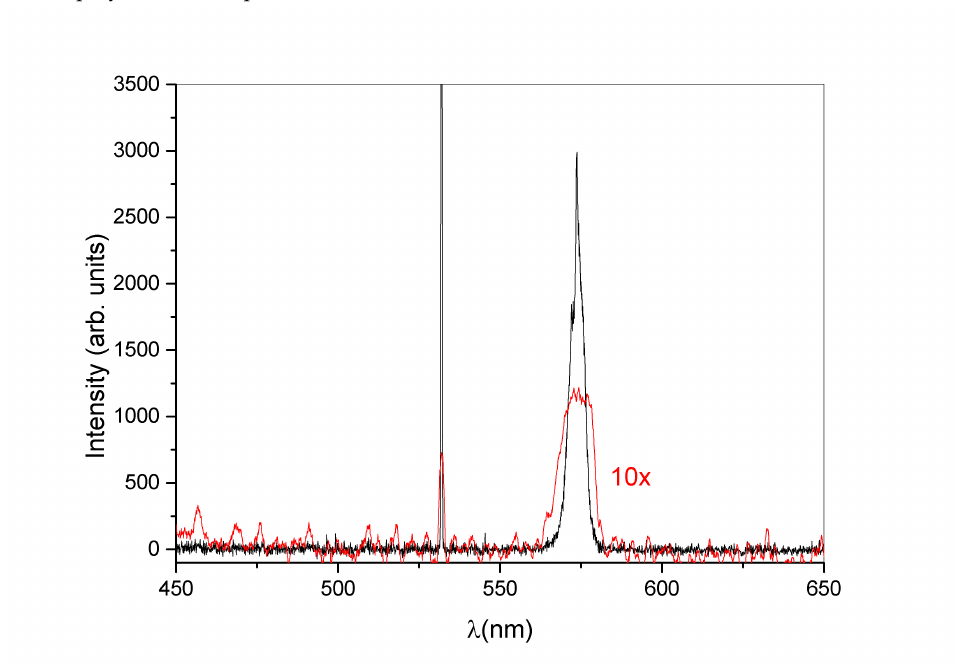
Figure 3. Lasing from the DFB structure under pulsed pumping at λ = 532 nm, pumping energy = 120 mJ. The narrow peak on the left side is due to the pump beam. The red line repre- sents a 10 × magnification of the typical emission spectrum of our mixture when pumped at low power